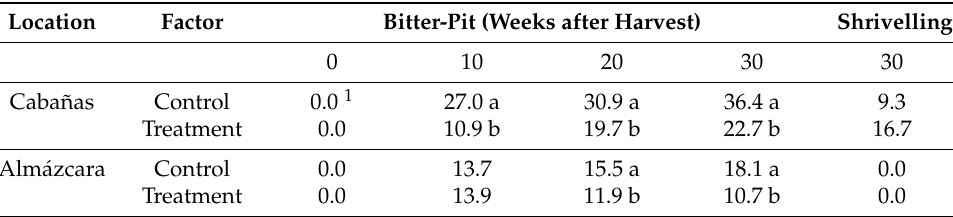
Table 3. Effect of pruning on bitter pit and shriveling incidence (%) in apple cv. ‘Reinette du Canada’ at harvest and during